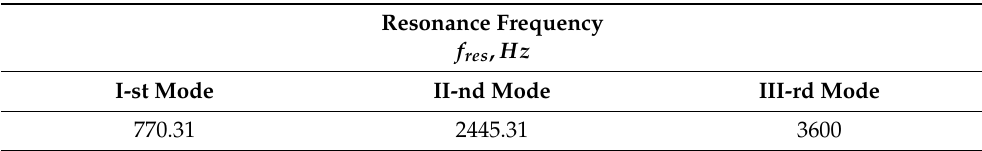
Table 1. List of the resonant frequencies of the compressor blade of the PZL-10W engine, experimen- tally estimated